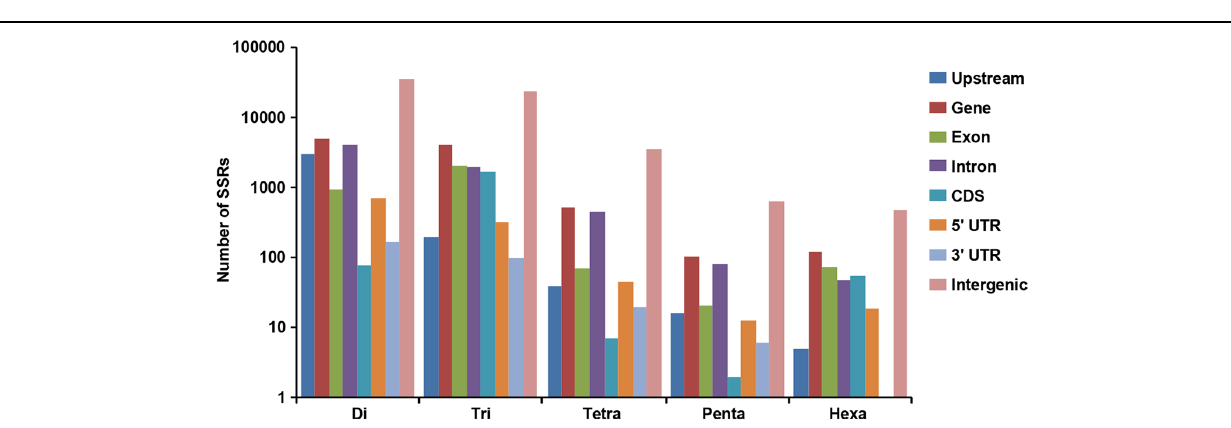
SSRs) followed by introns (6762), exons (3218), CDS